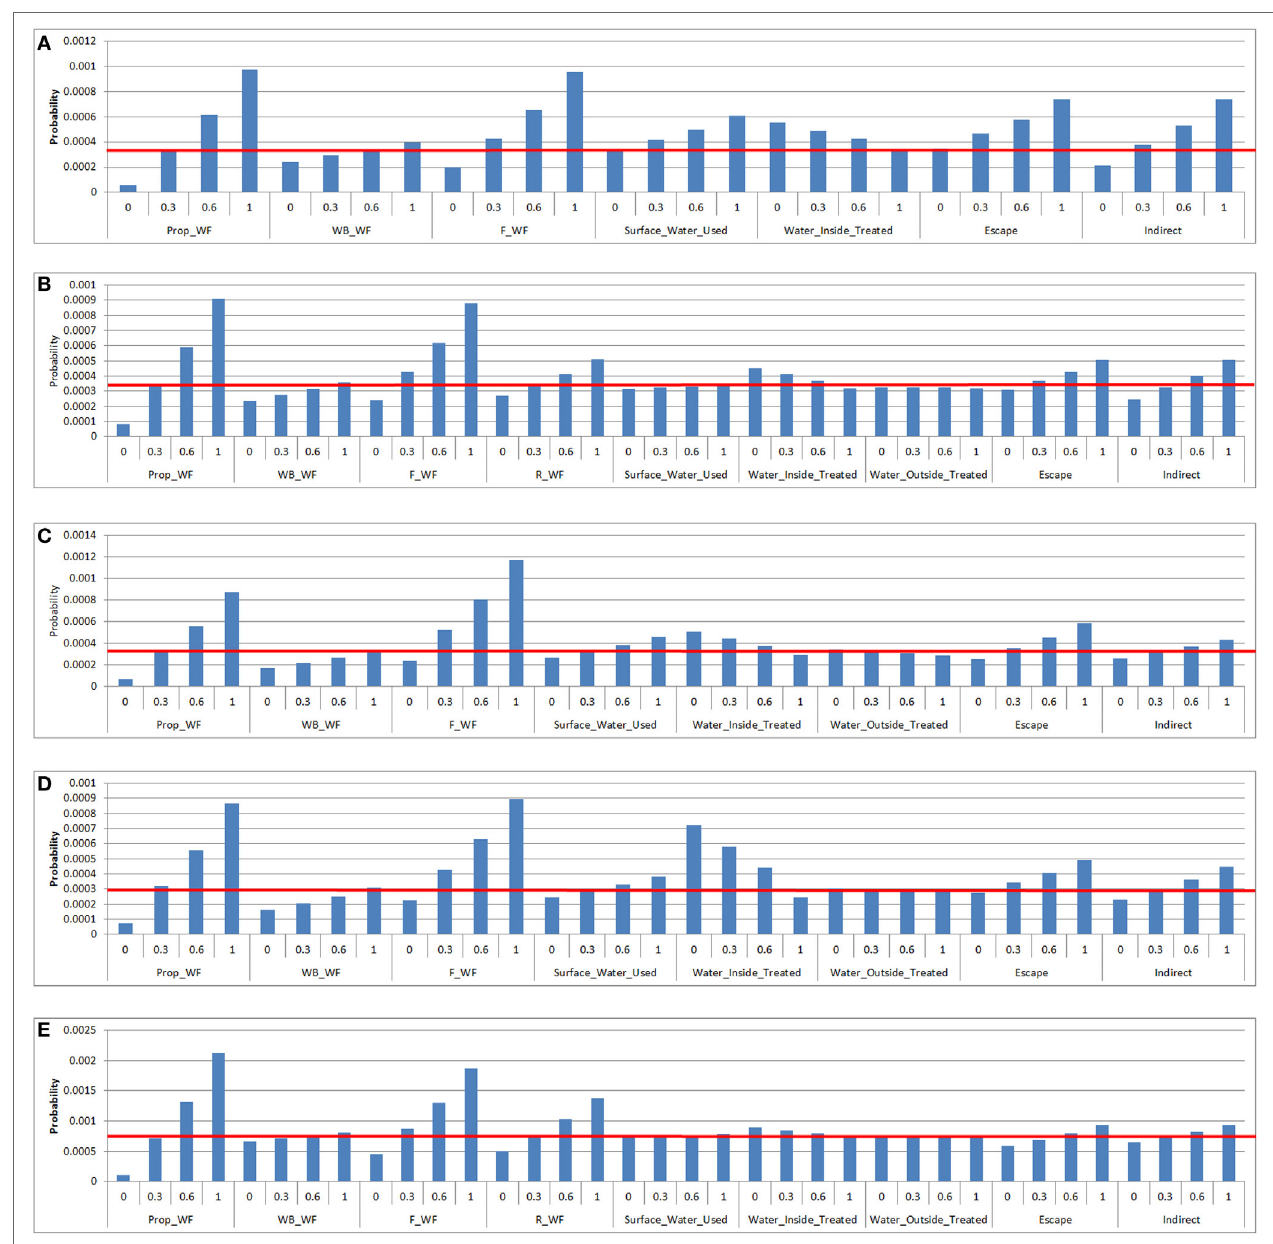
FigUre 5 | Results of the sensitivity analysis on the exposure assessment depicting the change in probability ( Y -axis) on the median overall probability of exposure (horizontal line) of a chicken on a commercial chicken farm to low pathogenic avian influenza (LPAI) virus from wild birds in Australia with changes of certain input variables listed in Tables 4 and 5 ( X -axis). Results were obtained from a simulation of 1,000 iterations using @Risk’s Advanced Sensitivity Analysis. [ (a) = non-free- range meat chicken; (B) = free-range meat chicken; (c) = cage layer; (D) = barn layer; (e) = free-range layer]; Prop_WF, proportion of waterfowl reported on property, WB_WF, proportion of responses that witnessed waterfowl in waterbodies on/near the farm, F_WF, proportion of responses that witnessed waterfowl in feed storage areas, R_WF, proportion of responses that witnessed waterfowl on the range, Surface_Water_Used, proportion of responses that use surface water for the chicken farm, Water_Inside_Treated, proportion of responses that treat water used inside sheds, Water_Outside_Treated, proportion of responses that treat water used outside sheds, Escape, proportion of farms that reported chickens escaping from shed [and from range for (B) and (e) ], Indirect, probability of the occurrence of other indirect methods that can introduce LPAI (boots, mice/rats, insects, farm cats, or dogs)